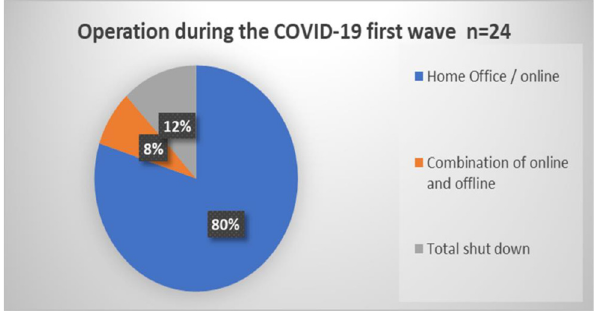
Figure 5: Way of operation of CSOs during the first wave of pandemic. Source: The chart was generated by the